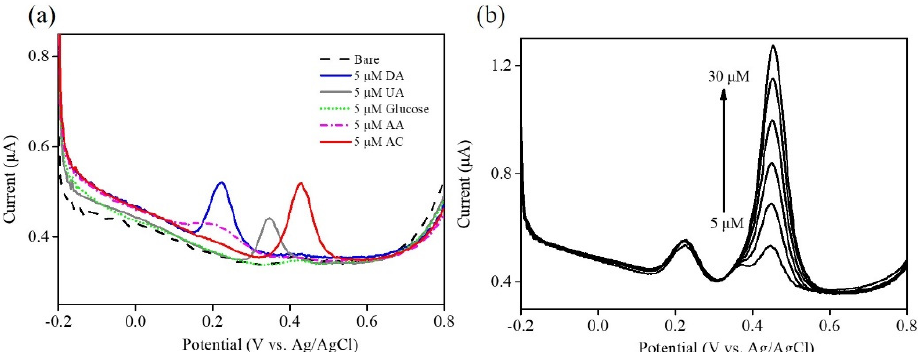
Figure 8. ( a ) Interference tests of Ni–Co–Te/Nafion-modified GCE using DPV in 0.1 M PBS (pH = 7.0) with the presence of 5 μ M DA, 5 μ M UA, 5 μ M Glu, 5 μ M AA, and 5 μ M acetaminophen (AC), respectively. ( b ) Interference tests of Ni–Co–Te/Nafion-modified GCE using DPV in 0.1 M PBS (pH = 7.0) with the successive addition of various acetaminophen concentrations (from 5 μ M to 30 μ M) coexisting with 5 μ M DA, 5 μ M UA, 5 μ M Glu, and 5 μ M AA. For real sample analysis, the Ni–Co–Te/Nafion-modified GCE was applied to the de- termination of acetaminophen concentration in commercial Panadol tablets obtained from the market (label claim: Acetaminophen 500 mg/tablet). Figure 9 displays the differential pulse voltammetric response in 0.1 M PBS (pH = 7.0) with the addition of various aceta- minophen concentrations (50, 100, and 200 μ M) from real samples (Panadol tablets). The preparation procedure of the tablet sample solution was as follows: each tablet containing 500 mg paracetamol was weighed and finely powdered in a mortar. The adequate amount of ground powder was transferred into a 10 mL volumetric flask and dissolved in 0.1 M PBS (pH = 7.0) to obtain final acetaminophen concentrations of 50, 100, and 200 μ M. The results for real sample analyses are given in Table 3, which shows that good recovery (98.46~99.85%), precision (calculated by the relative standard deviation, RSD) (0.79~1.86%), and accuracy (calculated by relative error, RE) (0.25~1.54%) were obtained through measurements repeated three times. Therefore, Ni–Co–Te nanocomposites have accurate and reliable detection results for electrochemical acetaminophen sensing of a commercial acetaminophen tablet, illustrating that Ni–Co–Te nanocomposites have po- tential usefulness for practical application. Figure 9. Real sample analysis (commercial Panadol (500 mg/tablet)) of Ni–Co–Te/Nafion-modified GCE using DPV in 0.1 M PBS (pH = 7.0) with the addition of various acetaminophen concentrations (50, 100, and 200 μ M).